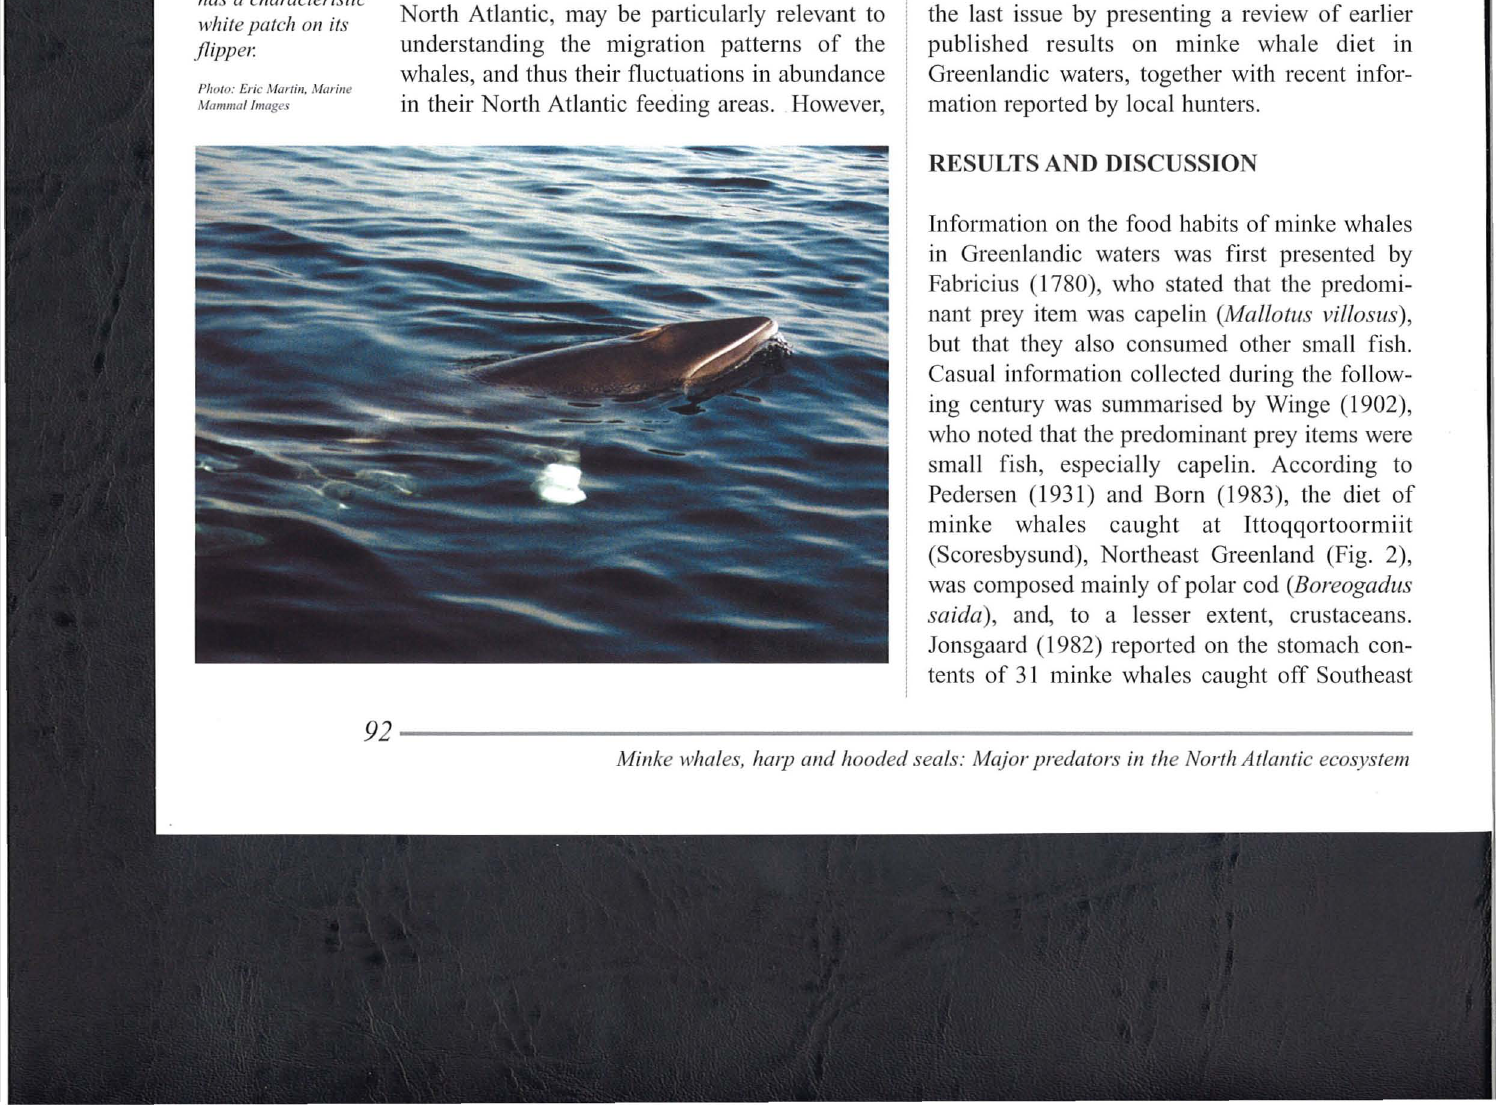
Fig. 1. The minke whale has a characteristic while patch on